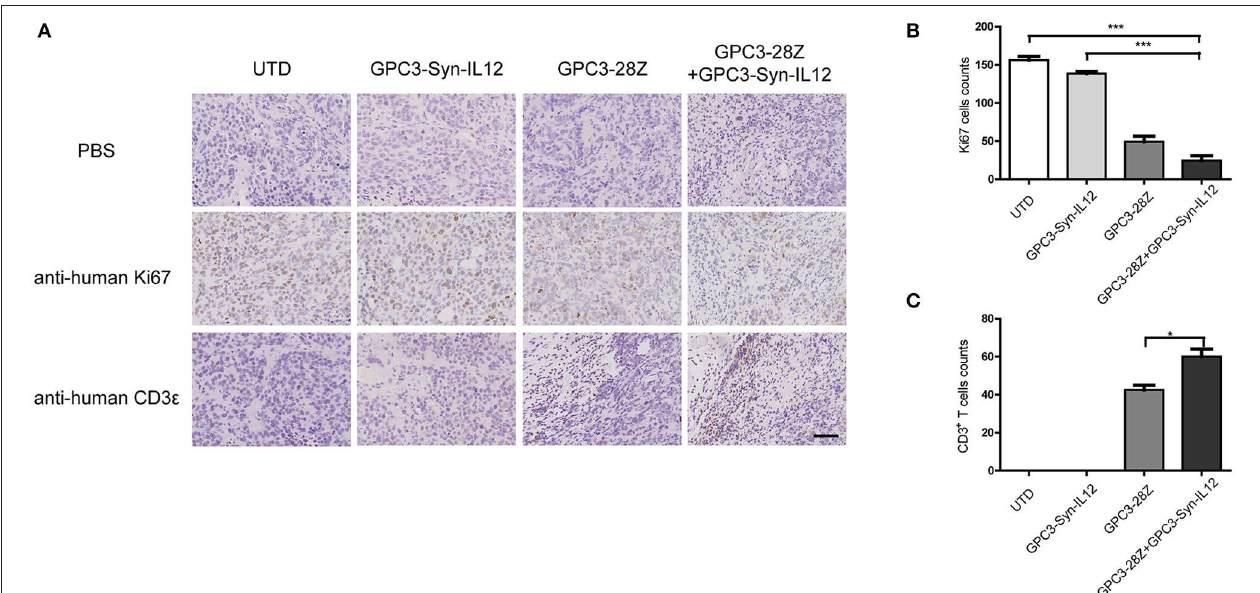
FIGURE 5 | Immunohistochemical (IHC) analysis of Ki67 and CD3 in tumor sections. (A) Representative tumor sections stained with Ki67 and CD3 are shown. Tumors were collected from mice bearing subcutaneous xenografts treated with the indicated T cells for 27 days. The images were obtained under 200 × magnification. The scale bar was 100 µ m. The data shown are representative of experiments with similar results. The images were obtained under 200 × magnification. (B,C) , Quantification of tumor cells proliferation and human T cells infiltration in tumor sections. The data shown are representative of experiments with similar results. Data are presented as the mean ± SEM. Statistical significance was calculated by two-way analysis of variance (ANOVA). * P < 0.05, *** P < 0.001. Only significant differences are